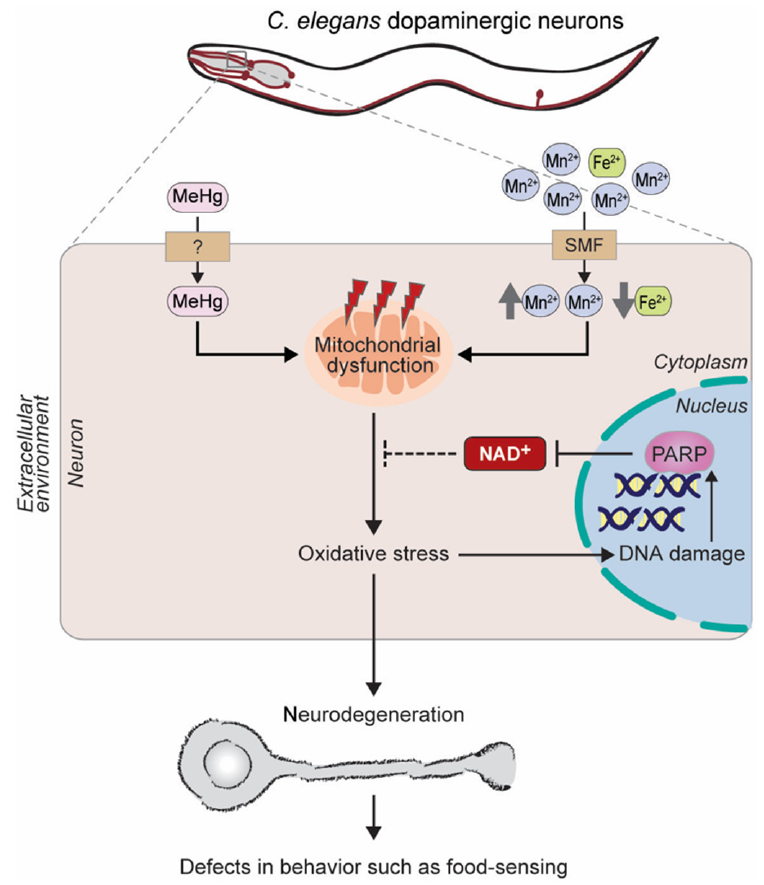
Figure 5. C. elegans models of Parkinson’s disease with chronic heavy metals treatments. Methylmercury (MeHg) and excess manganese (Mn 2+ ) lead to a dopaminergic neuronal loss resembling Parkinson’s disease. (Left) Methylmercury is transported across the membrane into the dopaminergic neuron and induces mitochondrial dysfunction, oxidative stress, and, finally, neurodegeneration. (Right) Excess manganese hinders iron transport, and iron deficiency causes mitochondrial dysfunction, oxidative stress, and DNA damage. PARPs are activated to prevent DNA damage, but an excessive PARP activity leads to NAD + depletion, which presumably fails to reduce oxidative stress, and eventually induces dopaminergic neurodegeneration. SMF, divalent cation transporter.